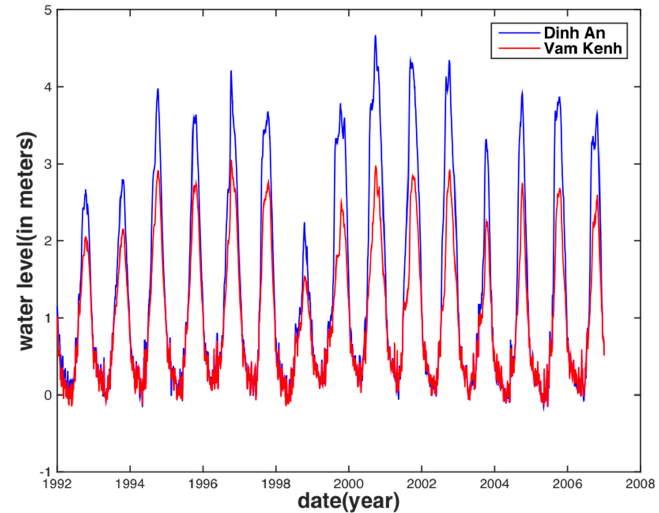
Figure 2. Time series of water level at the Dinh An (blue) station and Vam Kenh (red)